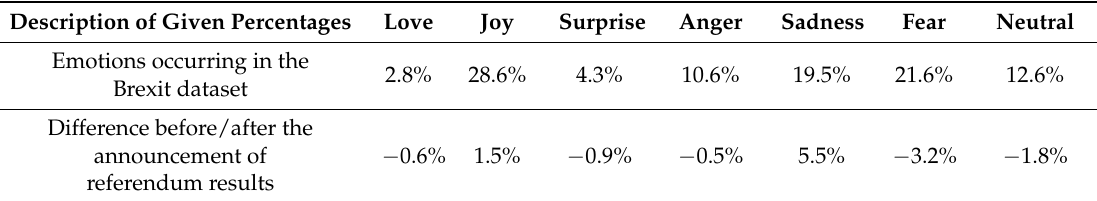
Table 5. Percentages of emotions that occur in the Brexit dataset and the difference between percentages prior to and past the announcement of the referendum results.